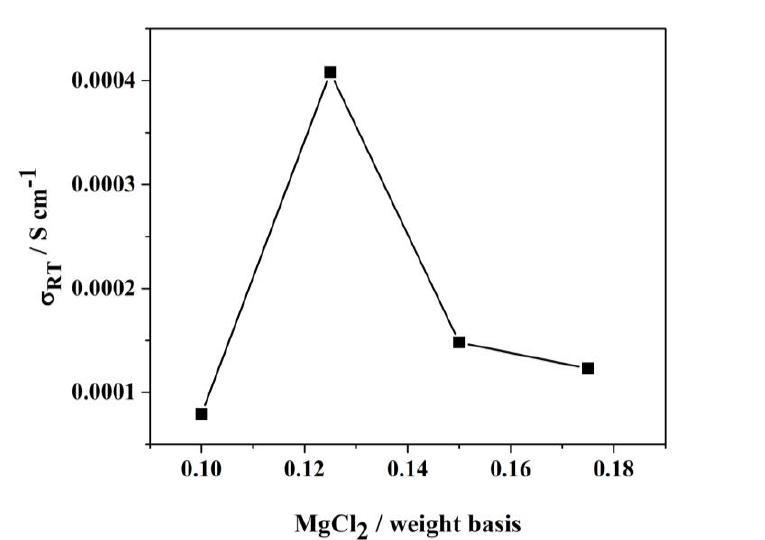
Figure 1: Room temperature ionic conductivity variation of the gel polymer electrolyte with MgCl 2